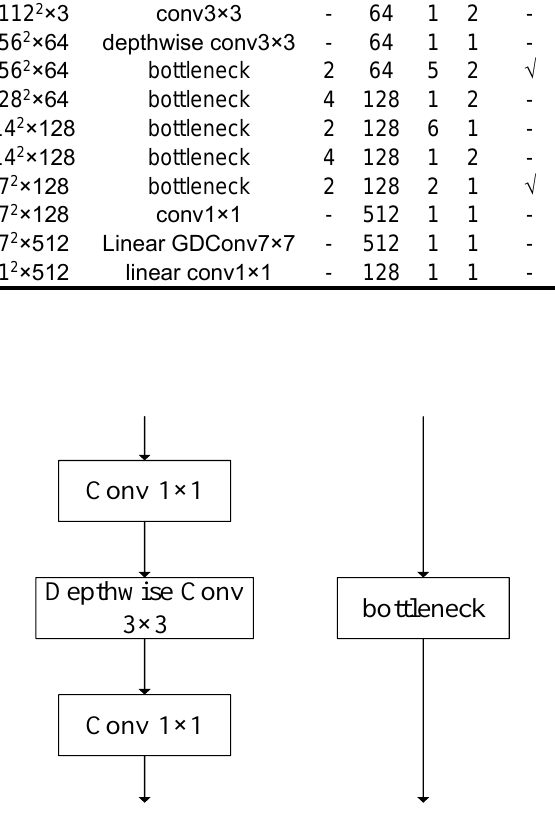
Figure 1. Bottleneck layer structure